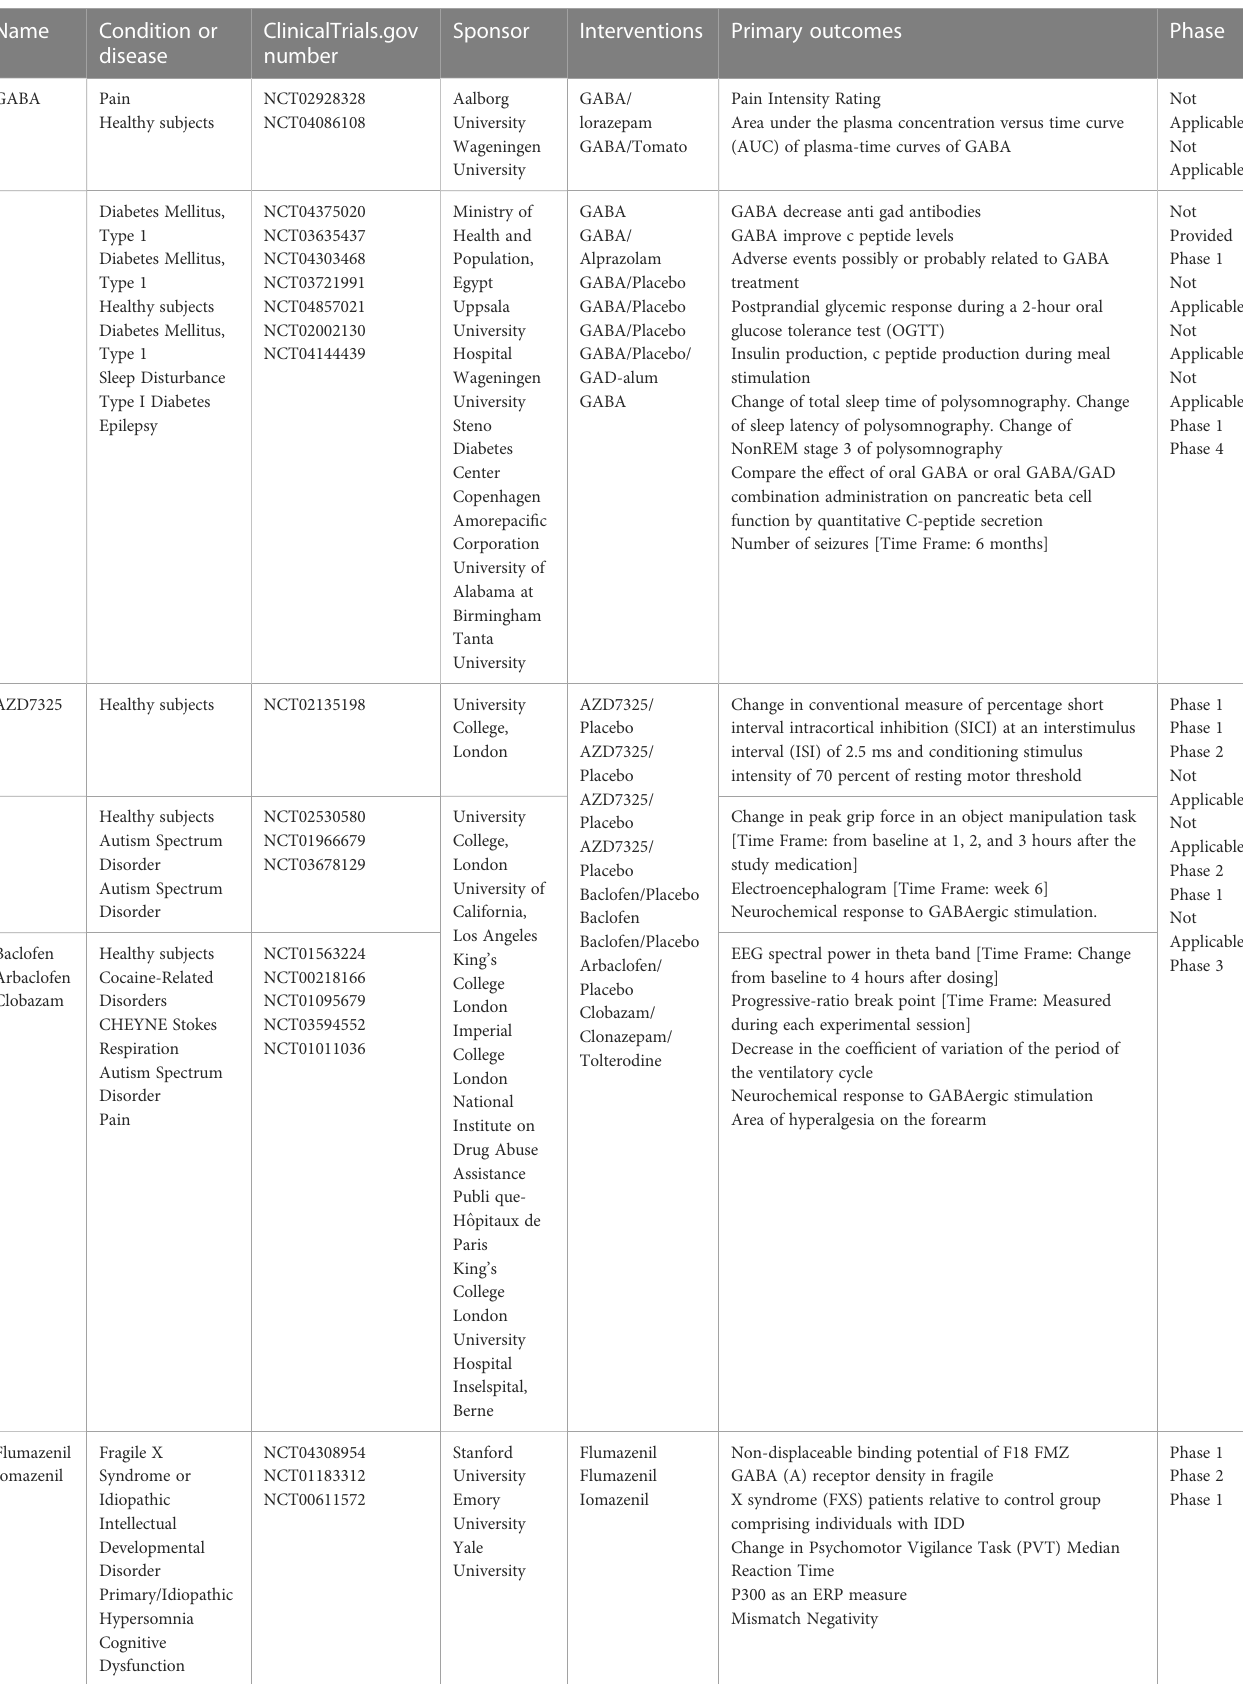
TABLE 1 Clinical trials of GABAergic system components.